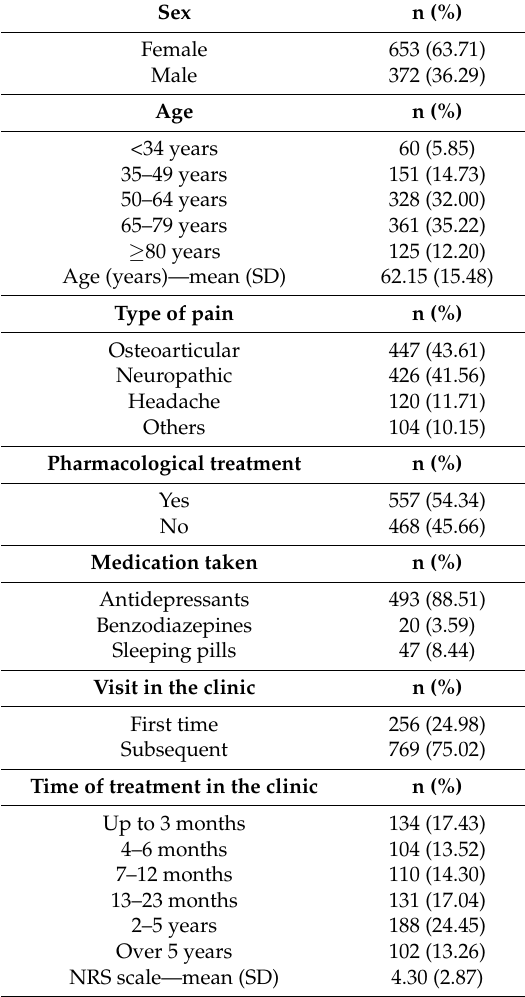
Table 1. Characteristics of the patients examined.